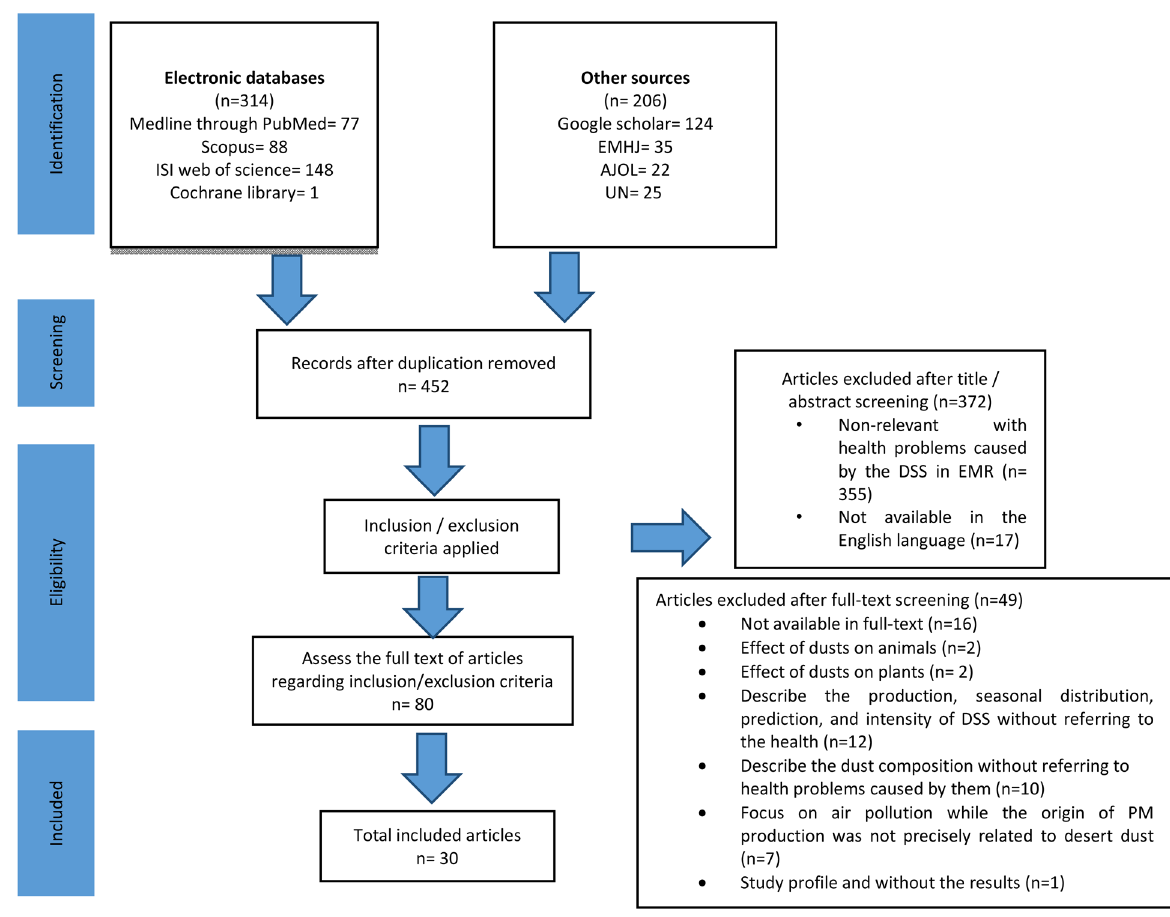
Figure 1. PRISMA flowchart to extract effective components on the preparedness of the health systems for DSS in the EMR until December 2017.